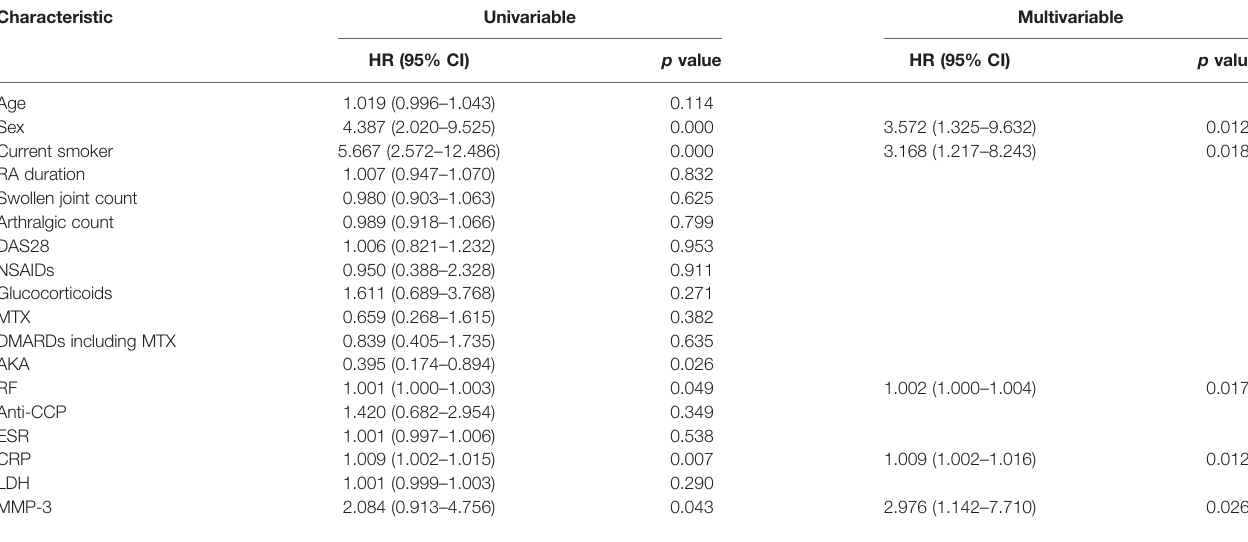
TABLE 3 | Univariate and multivariate logistic regression on variables for the prediction of ILD in RA patients.